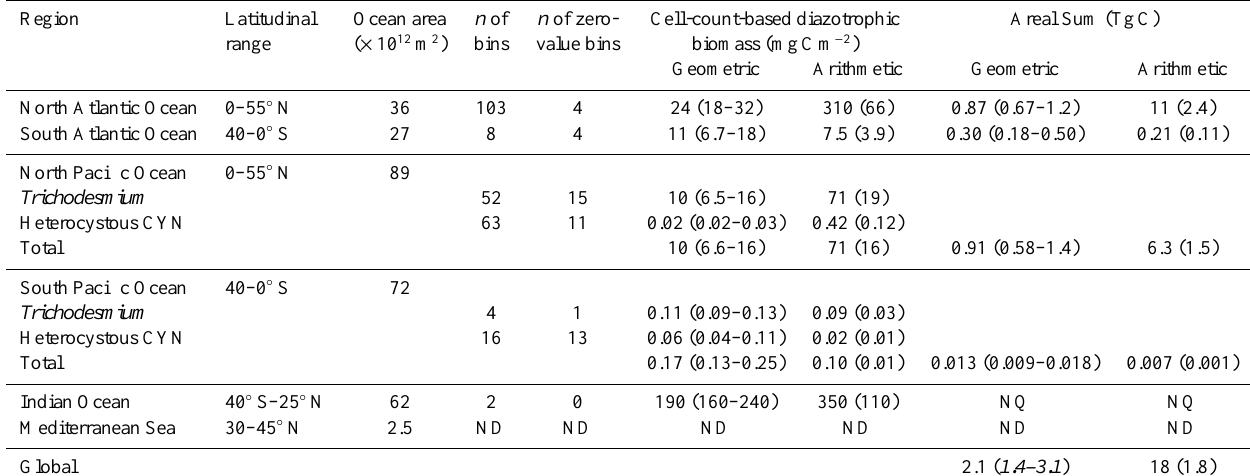
Table 7. Estimates of diazotrophic biomass for the global oceans using cell-count-based data. Same method as Table 6 is used, except that the estimates for Trichodesmium and Heterocystous cyanobacteria (CYN) are calculated separately in the North and South Pacific Ocean. ND: no data. NQ: not qualified to calculate areal sum because of too few samples.